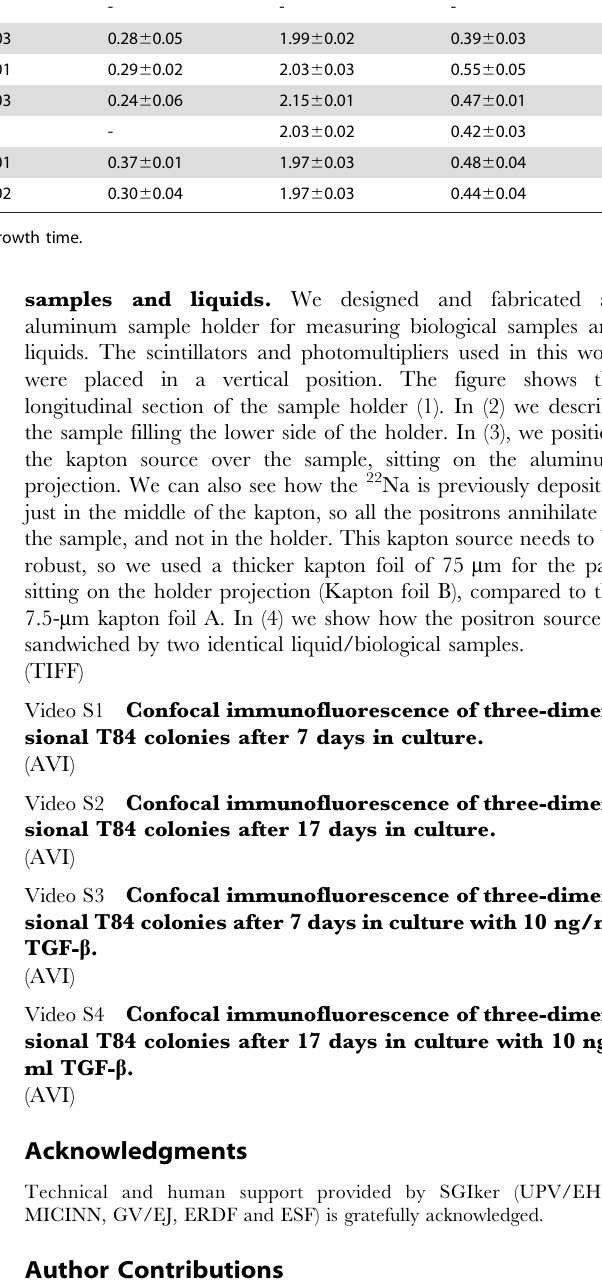
Collagen I Normal medium Supplemented with TGF- b Growth time